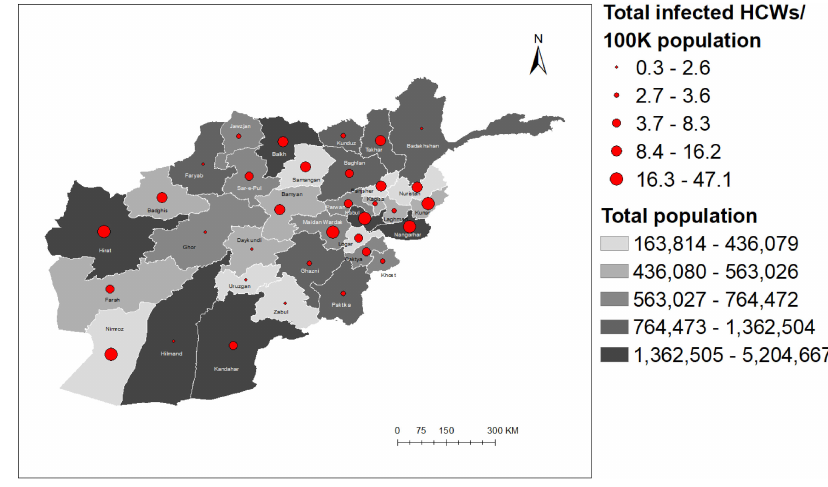
Fig. 4 A map of Afghanistan showing the distribution of total infected healthcare workers per 100,000 population by provinces from February 24, 2020 to November 03,